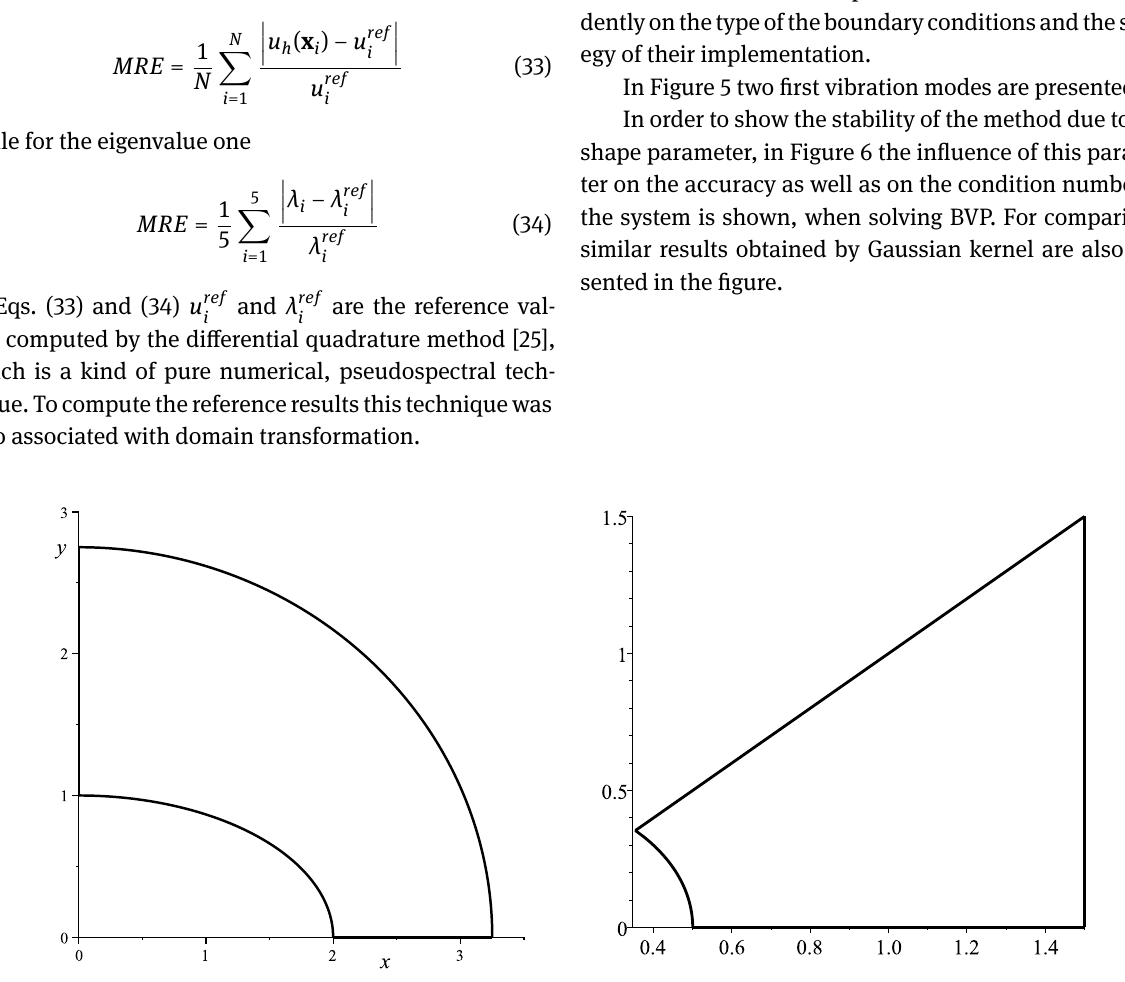
Figure 4: Shapes of the domains: quarter section of the elliptical domain (left), triangular domain with corner cut-out (right).